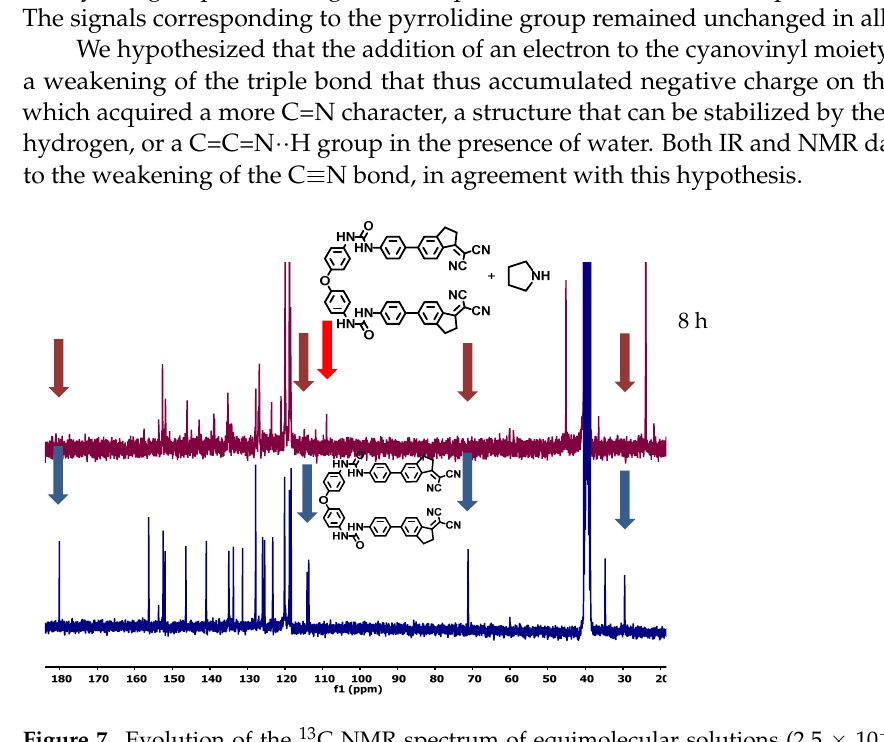
7 of 18 Figure 6. Evolution of the 1 H NMR spectrum of equimolecular solutions (2.5 × 10 − 3 M) of 1 + pyr- rolidine in DMSO- d 6 . The 13 C NMR spectrum of 1 is shown in Figure 7 in blue. The purple spectrum in Figure 7 was recorded 8 h after the addition of pyrrolidine, which shows the disappear- ance of the signals at δ 180 and 70 (corresponding to the exocyclic double bond), of the two peaks at around δ 114 (corresponding to the two cyano groups), and of the meth-